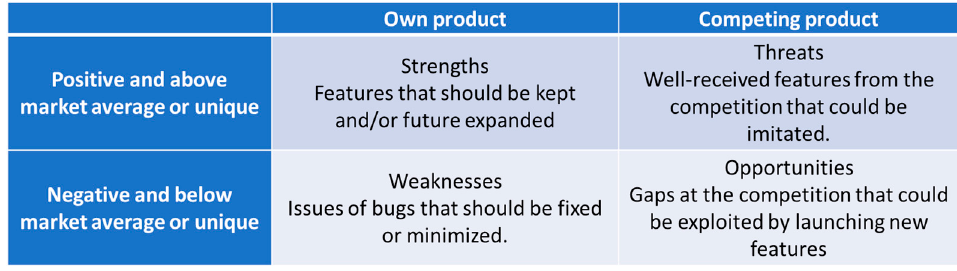
Figure 2. RE-SWOT matrix. Figure 2. RE-SWOT